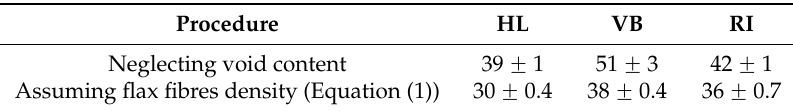
Table 1. Estimation of Fibres Volume Fractions v f (%).